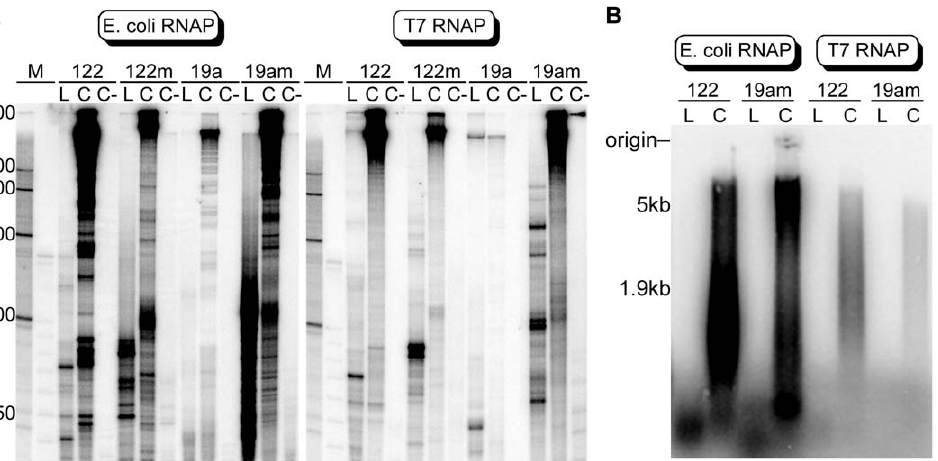
Figure 3. Invitro transcription of miRNA-encoding COLIGOs by E.coli and bacteriophage T7 RNA polymerases. A . Linear (L) and circular (C) templates 122, 122m, 19a, 19am, encoding either pre-miR-122 or pre-miR-19a, were transcribed in the presence of all NTPs or all except ATP (C-). 9% DPAGE. The Phosphorimager sensitivity setting was increased 5-fold for the weaker T7 RCT reactions. B . Denaturing 1% agarose gel showing the high molecular weight size range of the transcripts. No adjustment in the Phosphorimager sensitivity setting was